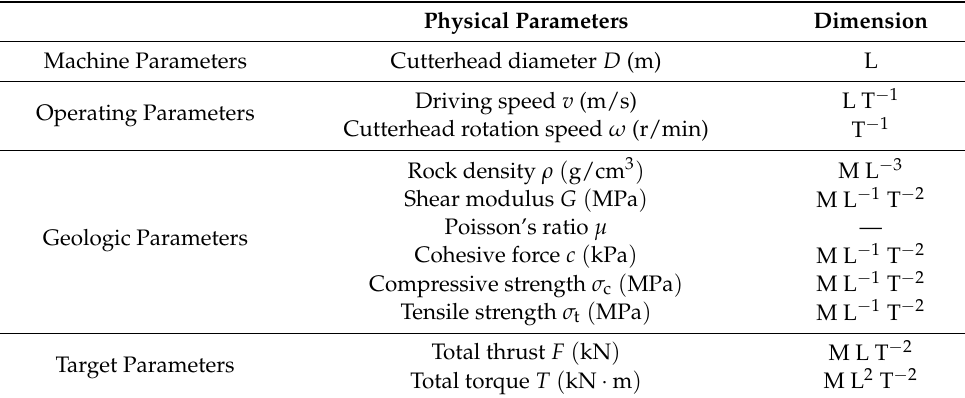
Table 1. Parameters and their dimensions.